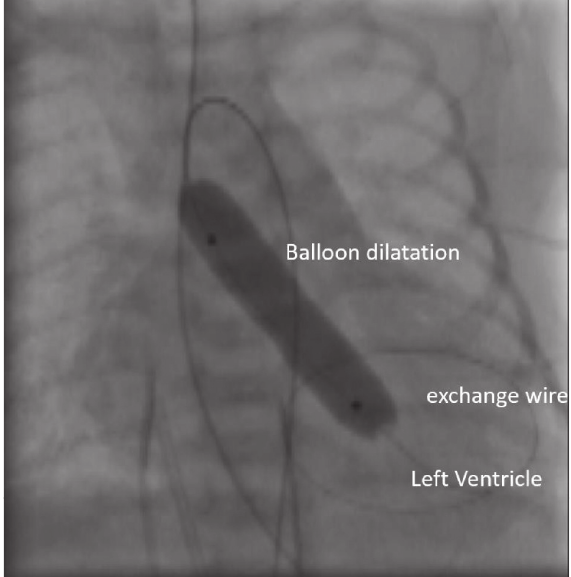
Figure 2: Selected cineradiographic frame showing a balloon positioned across the aortic valve for retrograde balloon valvulo- plasty. The inflated balloon is placed over an exchange wire in the left ventricle. Additional nasogastric and umbilical venous and arterial catheters are